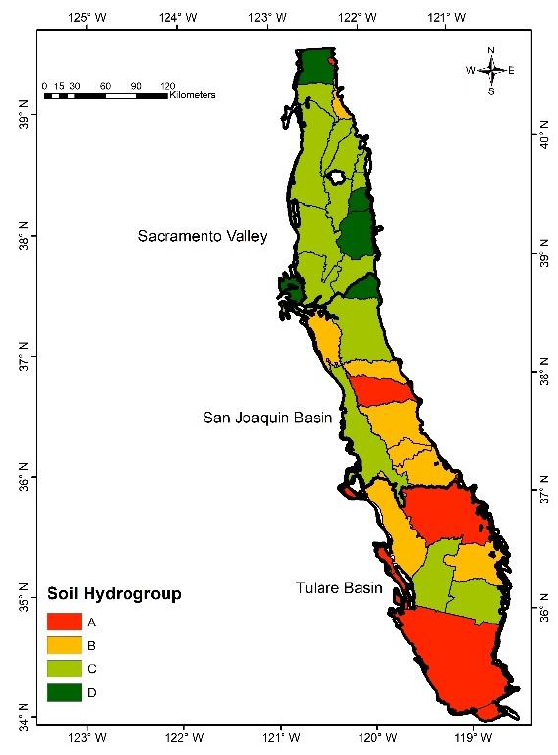
Figure 7. Soil Media in Central Valley